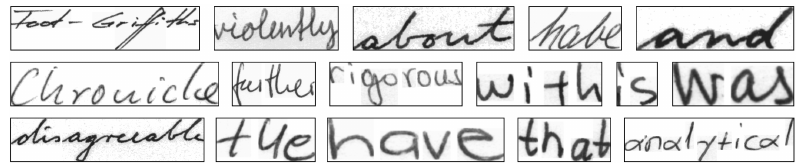
Figure 5. Sample images from the IAM dataset [21] used for